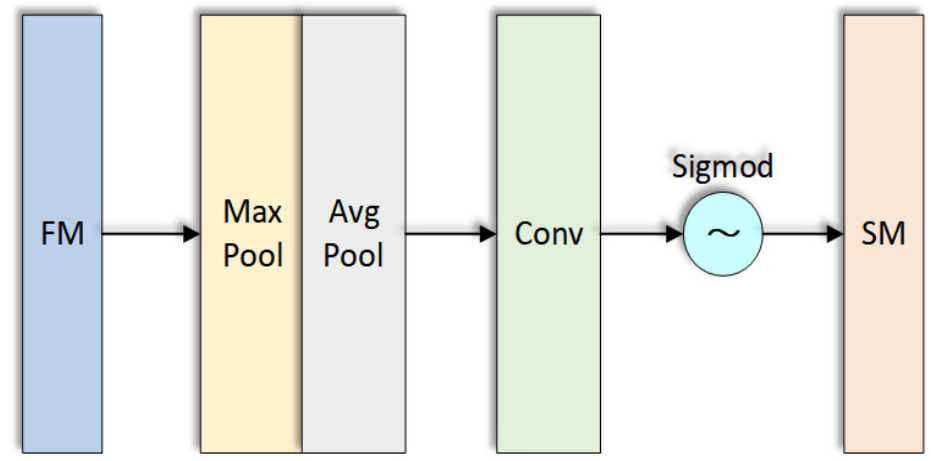
Figure 4. Structure of spatial attention module SAM.